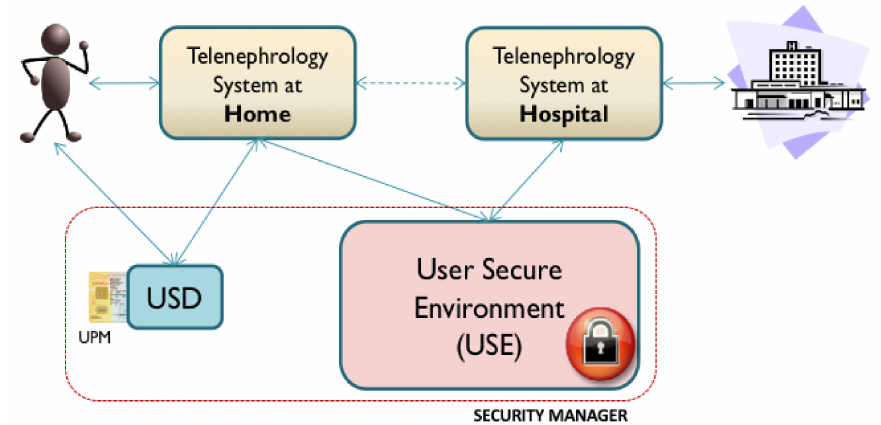
Figure 4. Overall graphic depiction of the components of the new security manager based on the User-Centered security architecture and the relationships between these and the telenephrology